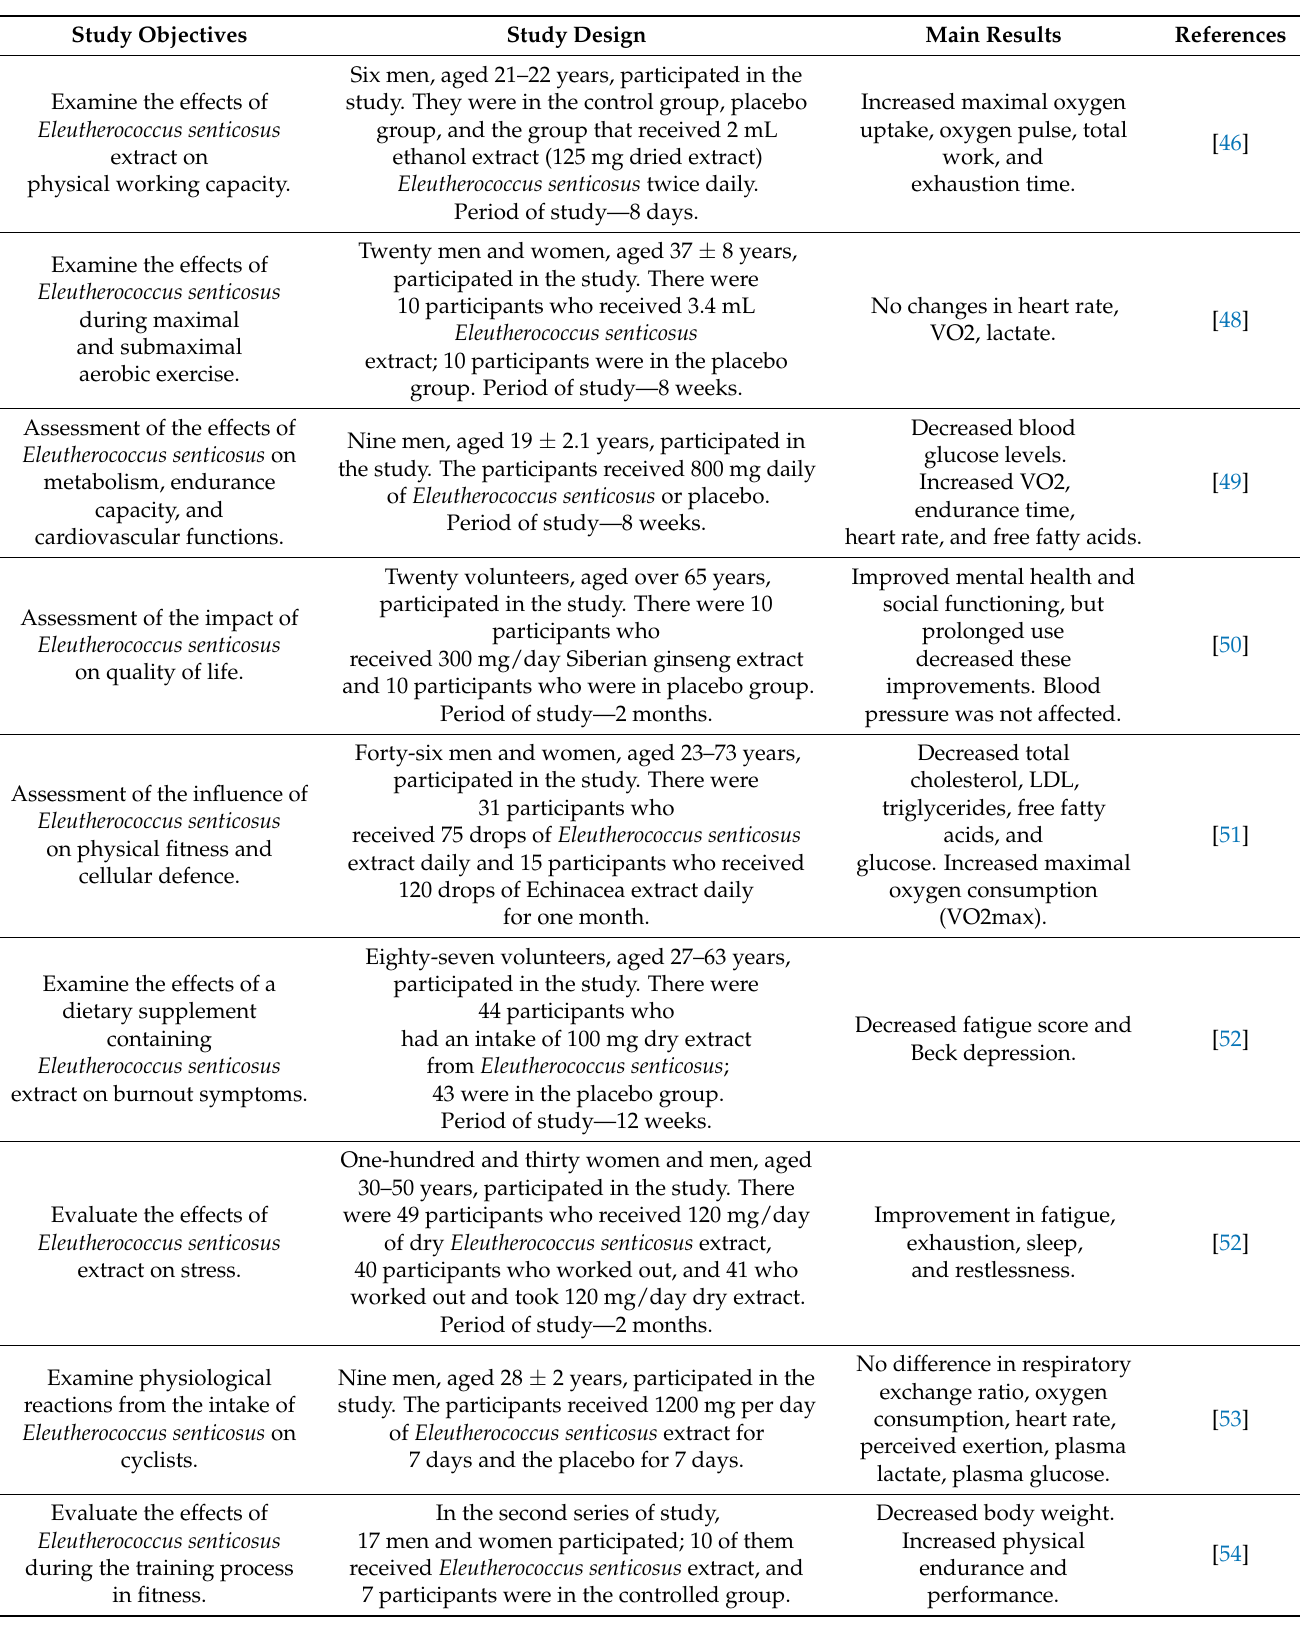
Table 2. Eleutherococcus senticosus